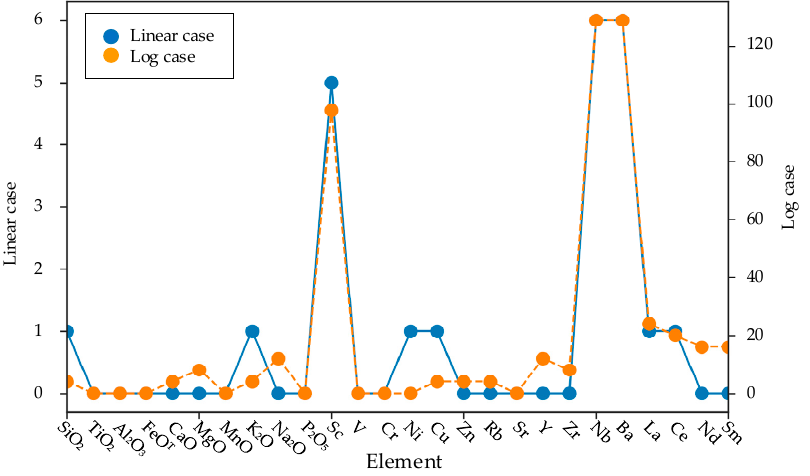
Figure 21. Word clouds of the top 20 important elements (or element ratios) for IAG–OIG–MORG discrimination diagrams. ( a ) is for linear coordinates; ( b ) is for logarithmic coordinates.